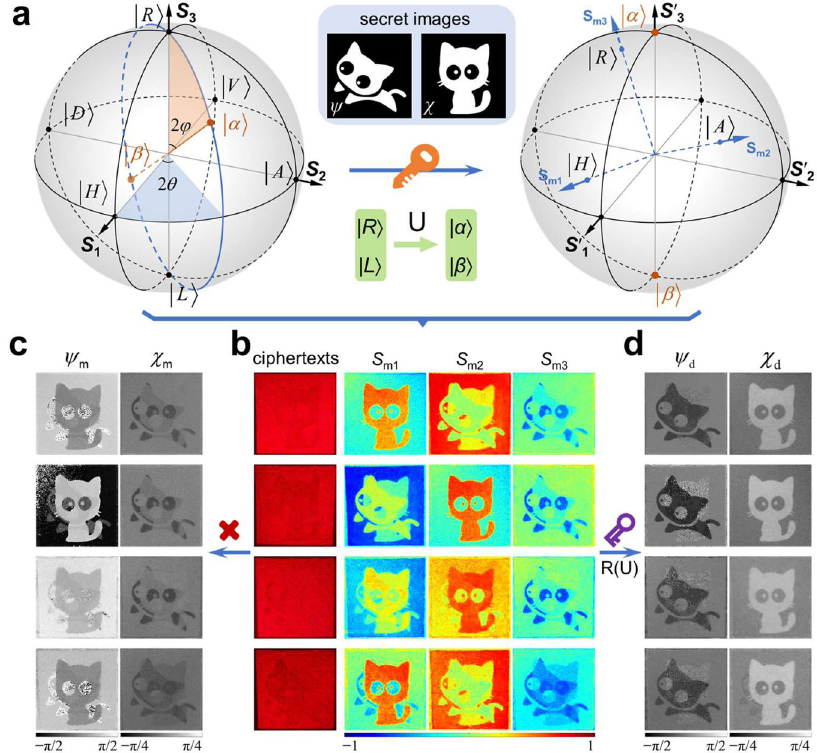
S S m2 , m3 ). c , d Decrypted images from measured information without and with the private key. The results shown in the fi rst to fourth rows of b – d correspond to the Poincaréspherewithdifferenteigenstates:| H 〉 -| V 〉 ,| A 〉 -| D 〉 ,| α 1 〉 -| β 1 〉 ,| α 2 〉 -| β 2 〉 ,andthe coordinates of | α 1 〉 and | α 2 〉 are ( π /3, π /2) and (0, π /3),